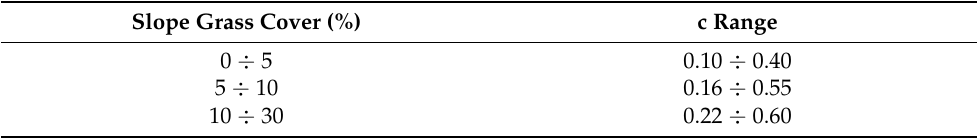
Table 1. Runoff coefficient values in the case of